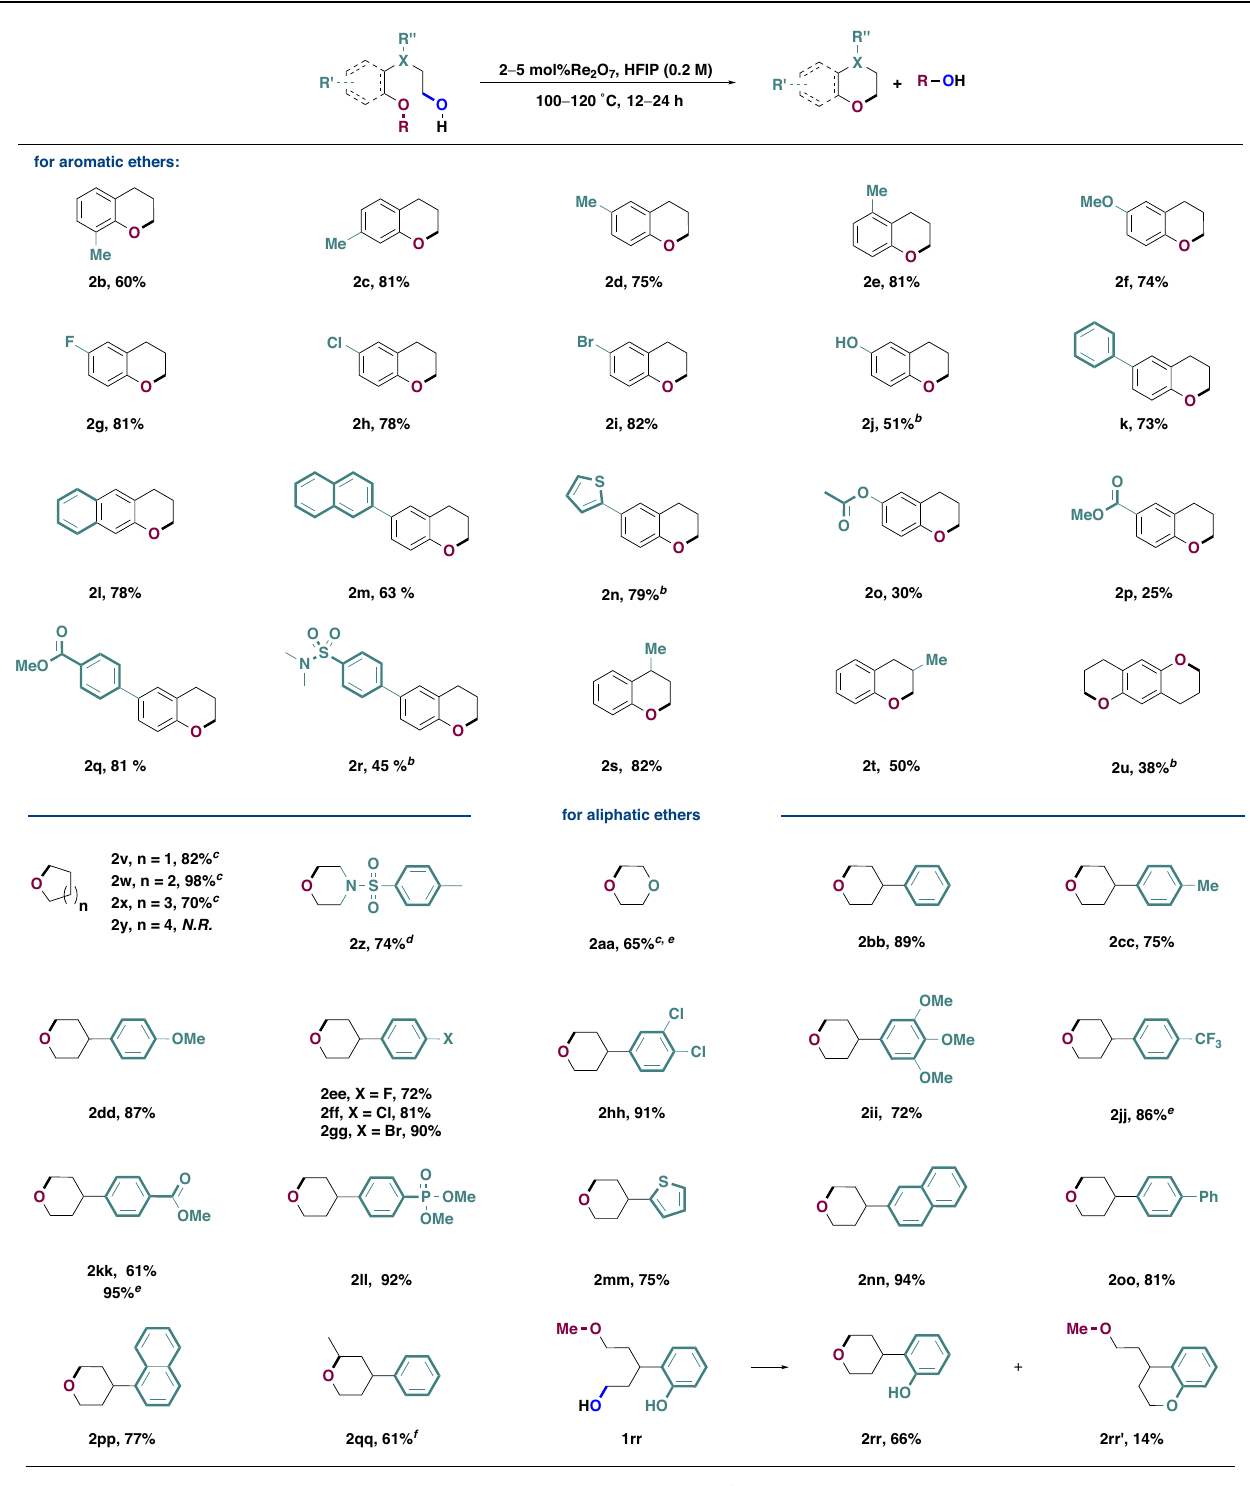
Fig. 2 | Ring-closing C – O/C – O σ -bond metathesis of ethers with alcohols. a Reactionconditions:reactionswereperformedwith 1 (1.0equiv.),solvent(0.2M), catalyst(2mol%)at100°Cfor12h, i solatedyieldswereprovidedunlessmentioned